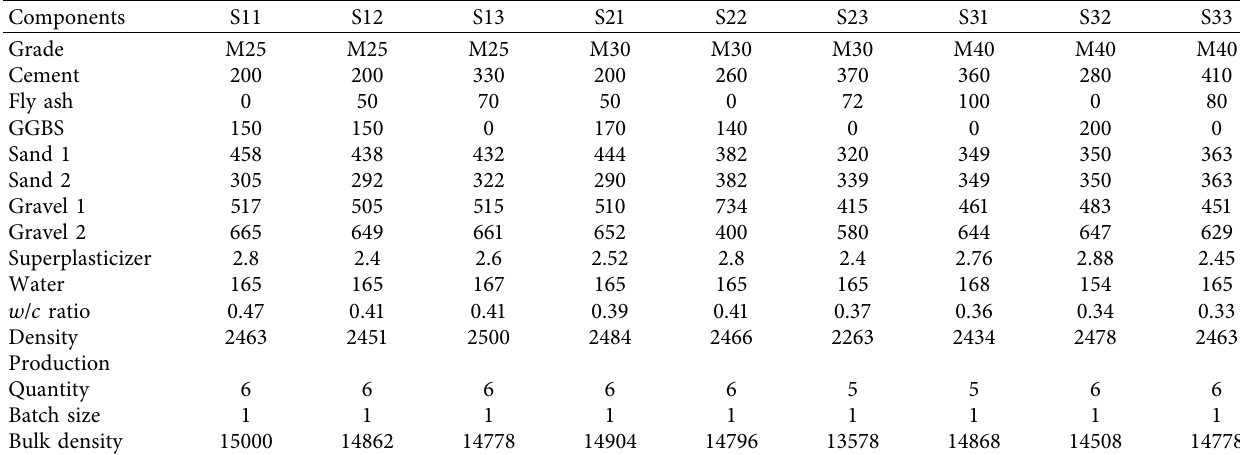
Table 9: Composition of the concrete ingredients.